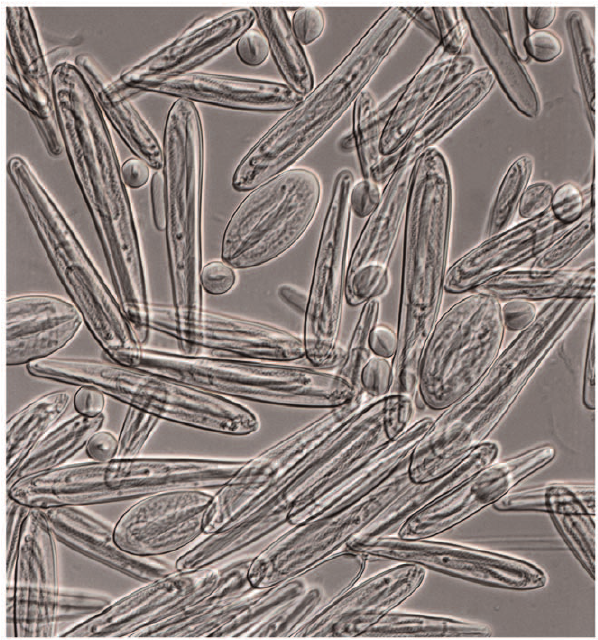
Figure 1. Chironexfleckeri nematocysts. Light microscopy image of nematocysts isolated from C. fleckeri tentacles (magnification 400 6